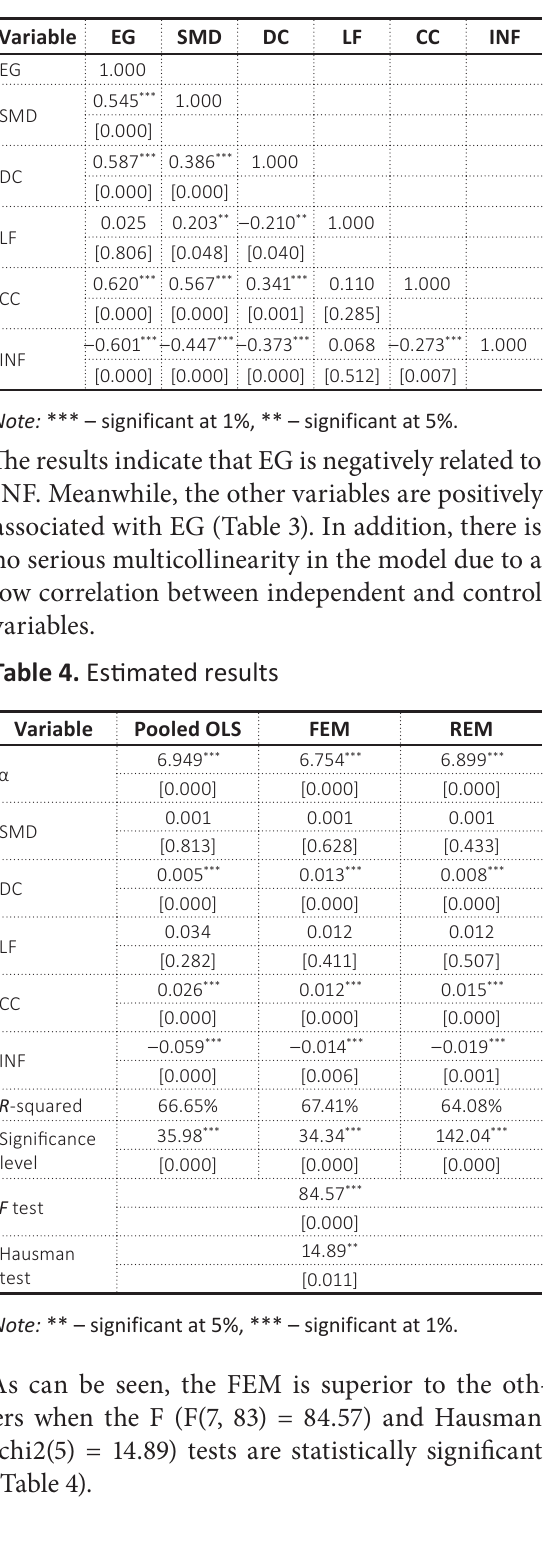
Table 2. Summary